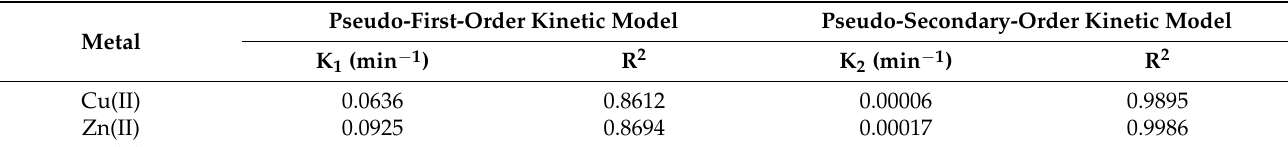
Table 2. Kinetic parameters for Cu(II), Mn(II), and Zn(II) ion adsorption onto aerogel spheres. Metal